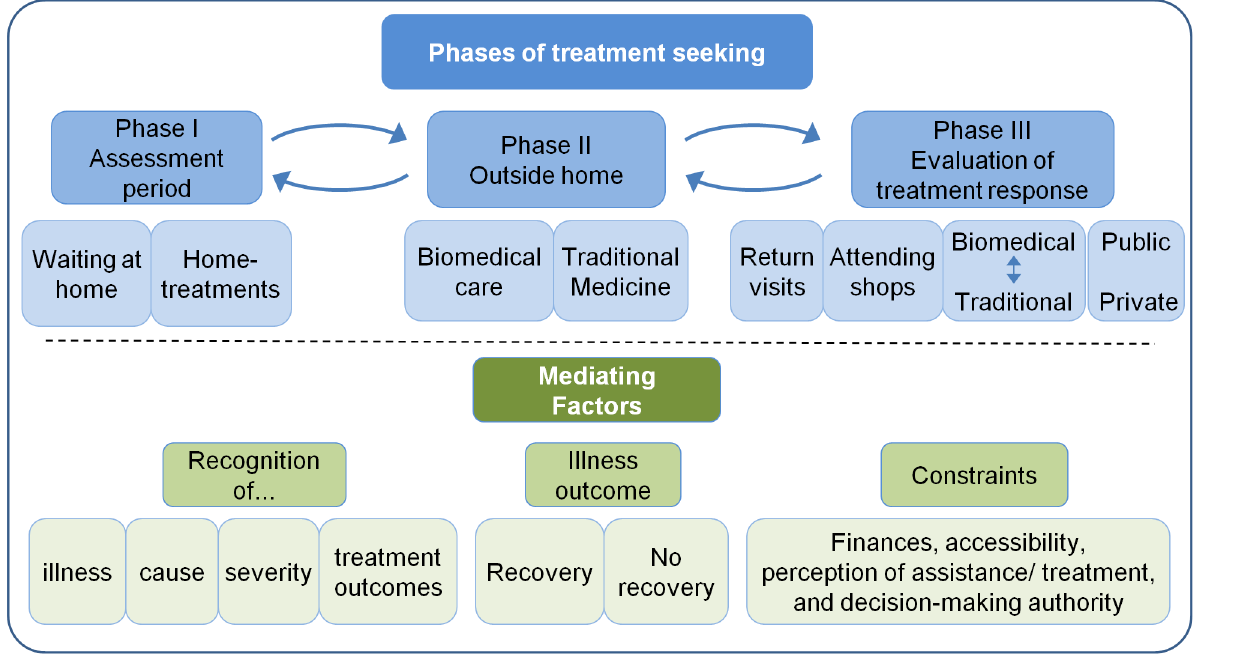
Fig 1. Diagrammatic representation of the treatment-seeking